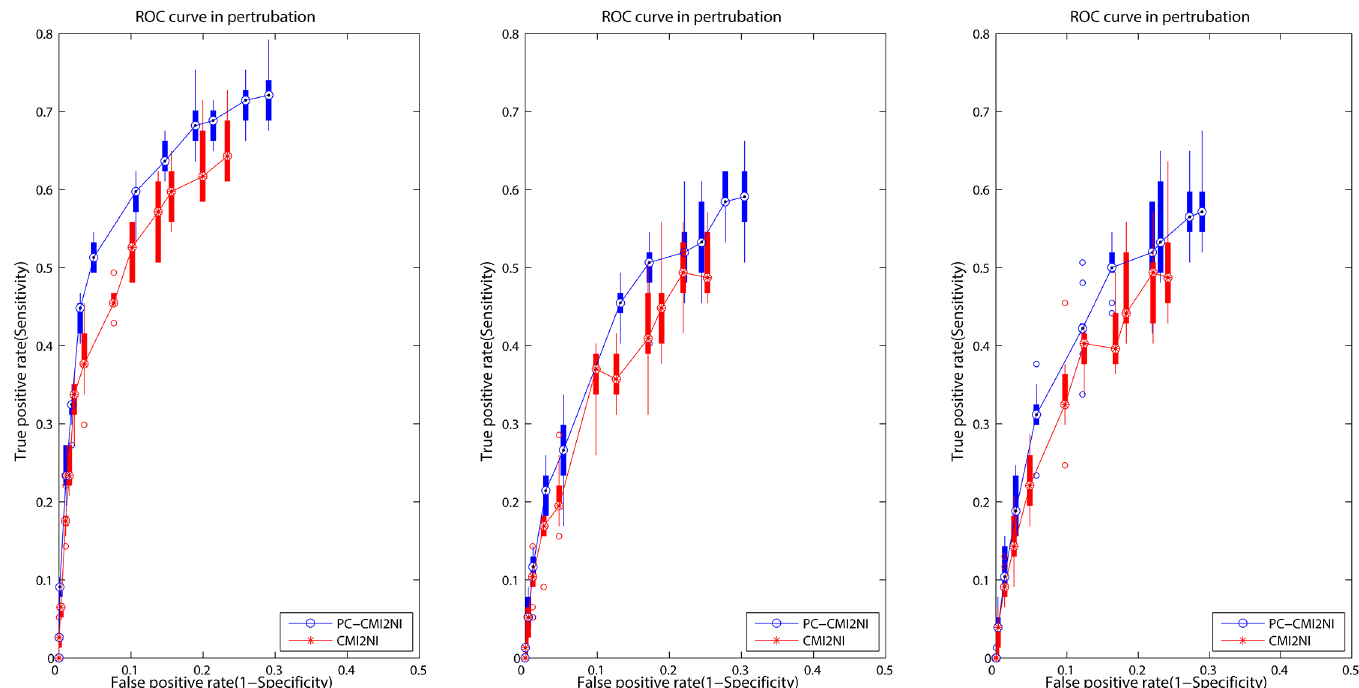
Fig 6. ROC curves of two methods of CMI2NI and RPNI using different types of noise. (A) ROC curves of two methods with noise. (B) ROC curves of two methods with outliers. (C) ROC curves of two methods with